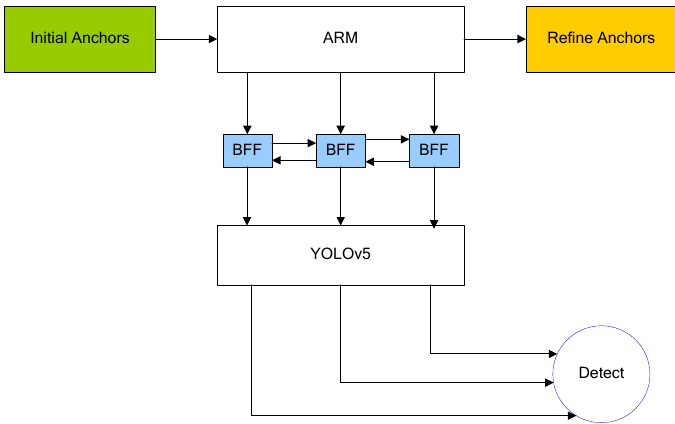
Figure 3. Dynamic anchor learning.